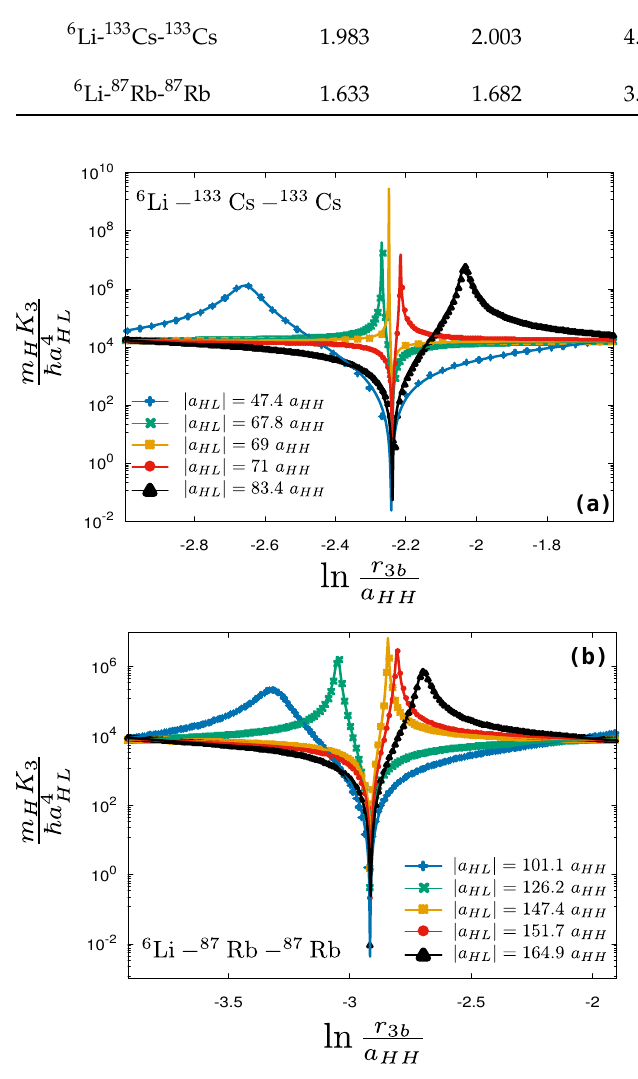
Figure 6. In the limit of E → 0, the scaled recombination coefficient m H K 3 of ln r 3 b for ( a ) 6 Li- 133 Cs- 133 Cs and ( b ) 6 Li- 87 Rb- 87 Rb. The symbols refer to the corresponding a HH calculations in the semi-classical approach. The solid lines indicate the fitting of Equation (15) using the universal parameters shown in Table